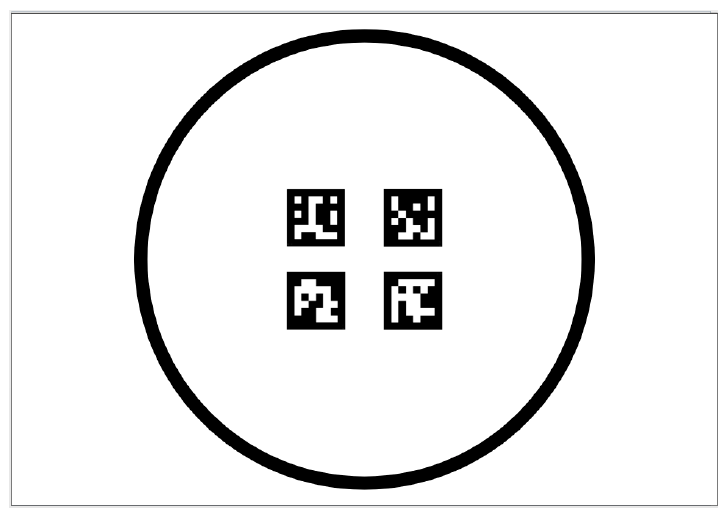
Figure 9. Markers on landing table: four 50 × 50 mm ArUco markers from standard dictionary (#12, #13, #14, and #15) inside a 260 mm diameter circle.